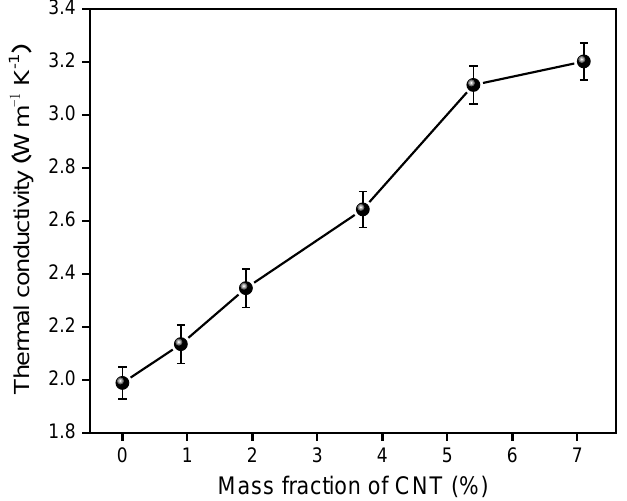
Figure 1. Thermal conductivity of the as-prepared CNT-PE-EPDM/EG-based PCMs.